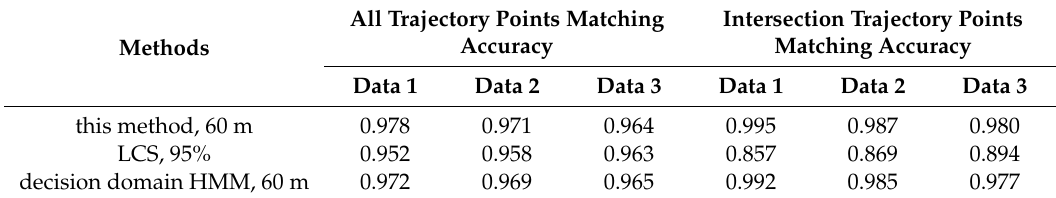
Table 3. Accuracy comparison